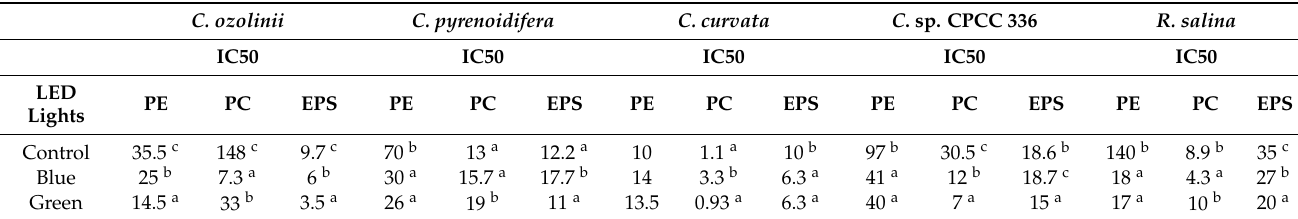
Table 2. Antioxidant activity (IC50, µ g mL − 1 ) of isolated chemical components from studied crypto- phyte algae cultured under three different LED